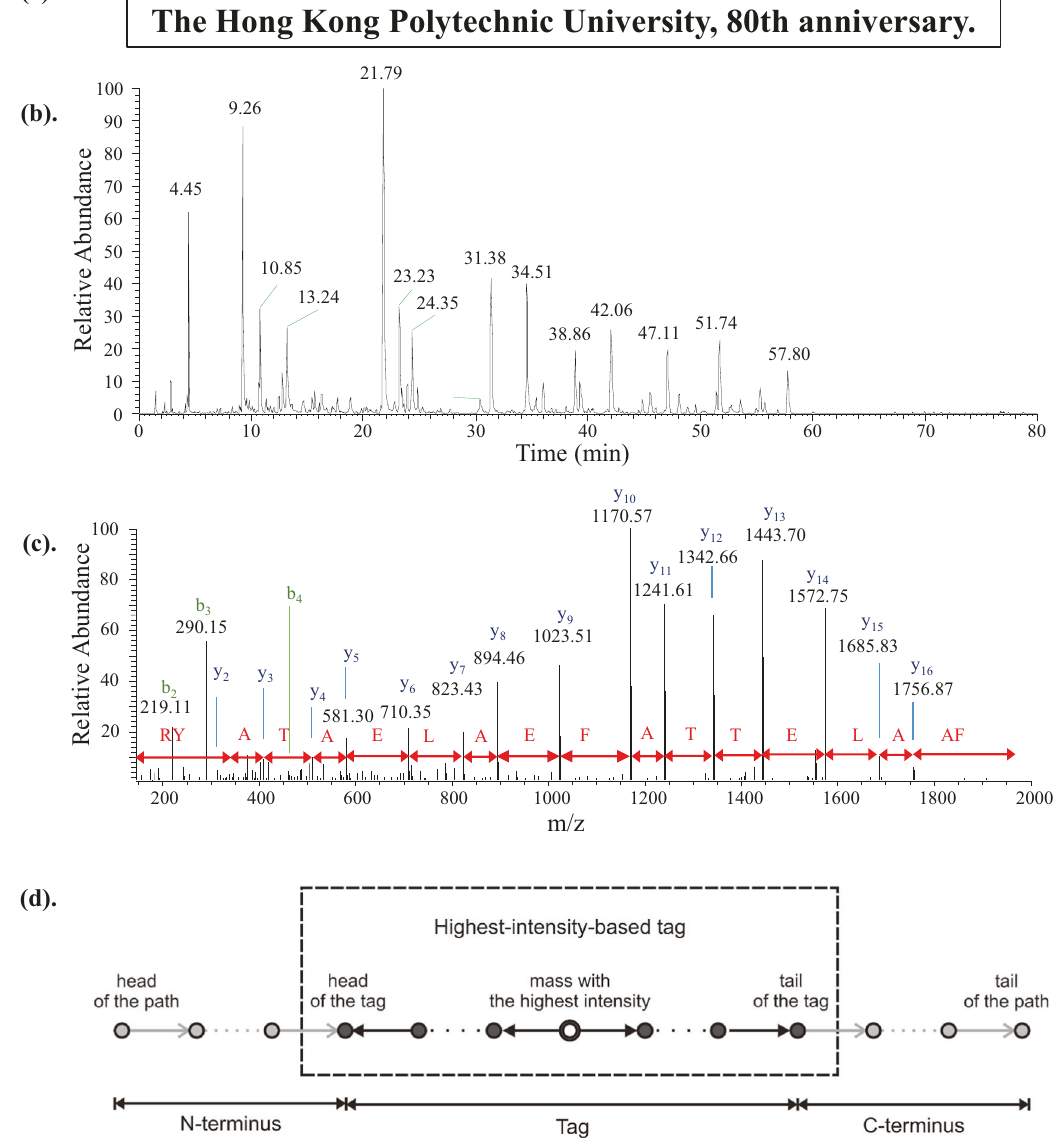
Fig. 2 Overview of data retrieval from dataset A. a The message of dataset A; b The chromatogram for analysis of the 40 peptides for dataset A; c A typical MS/MS spectrum for analysis of peptides in dataset A, and the sequence of one of the data-bearing peptide read out from the spectrum; d The highest-intensity-tag-based sequencing method used in the sequence recovery. represent a 16-mer data-bearing peptide sequence. In the design of encoding scheme for dataset A, the fi rst two symbols in each sequence were used to store the address, and the remaining 14 symbols were used to store information. Hence a total of 560 symbols are available in the 40 peptide sequences (total 560× 3 = 1680 bits, see Table S2 for the 40 peptide sequences). Then 850 information bits (i.e., b 1 , b 2 , … , b 850 ) were fi lled in the data block according to the following arrangements (Table S4):